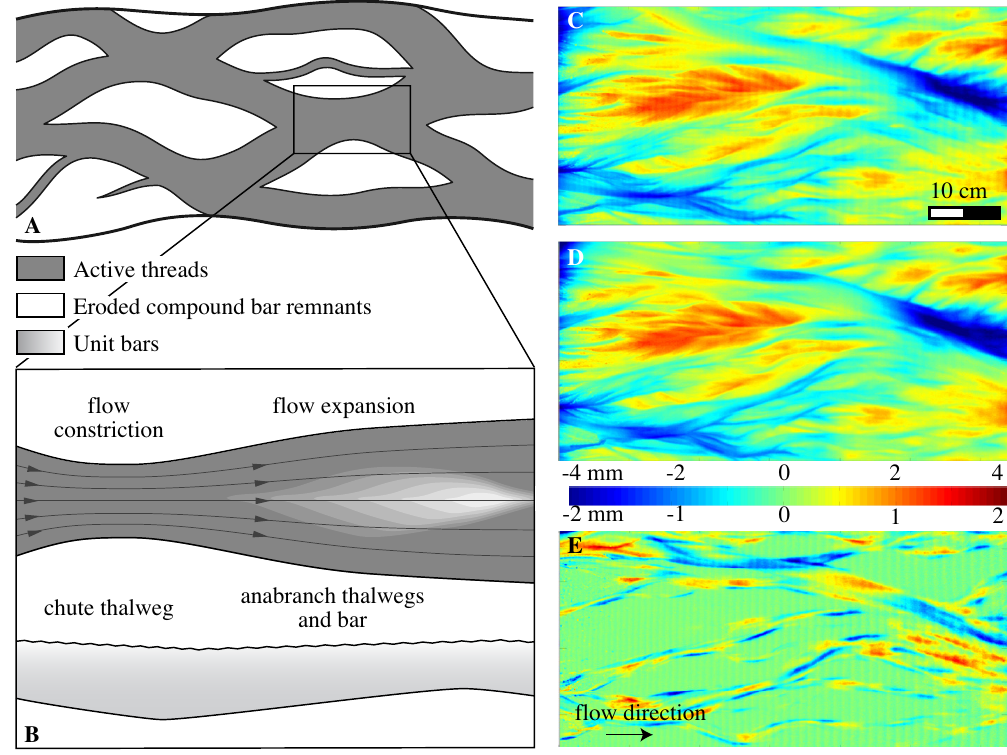
Fig. 1. Morphological features of the braided gravel-bed rivers at the scale of their (a) compound and (b) unitary morpho-sedimentary elements (in map view and longitudinal section). Note that (a) is considered to be exclusively composed of (b) . (c) and (d) Five minutes apart topography scans of the bed of an experimental braided river (modified from Limare et al., 2011). (e) Elevation differential map between the two previous topographies. Areas of erosion (in blue) and deposition (in yellow and red) alternate within the active threads, which surround stable areas of the braidplain (in green). This illustrates that sediment transport occurs in active threads